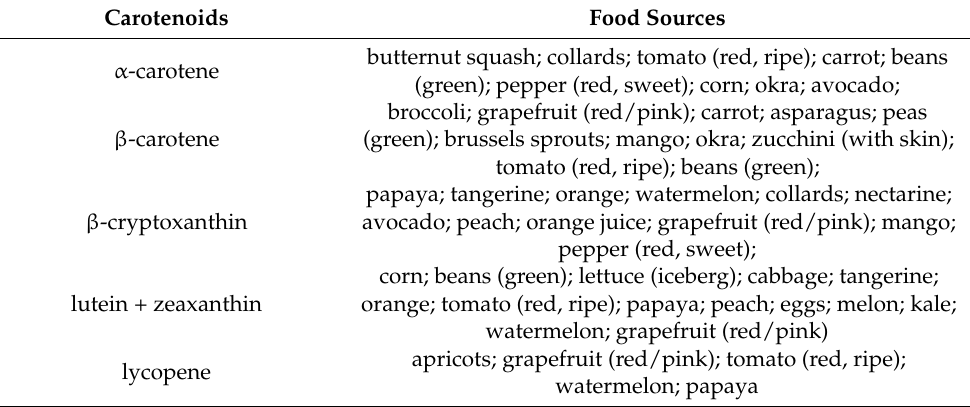
Table 2. Dietary sources of carotenoids [195,196]. Source: Own elaboration based on the indicated